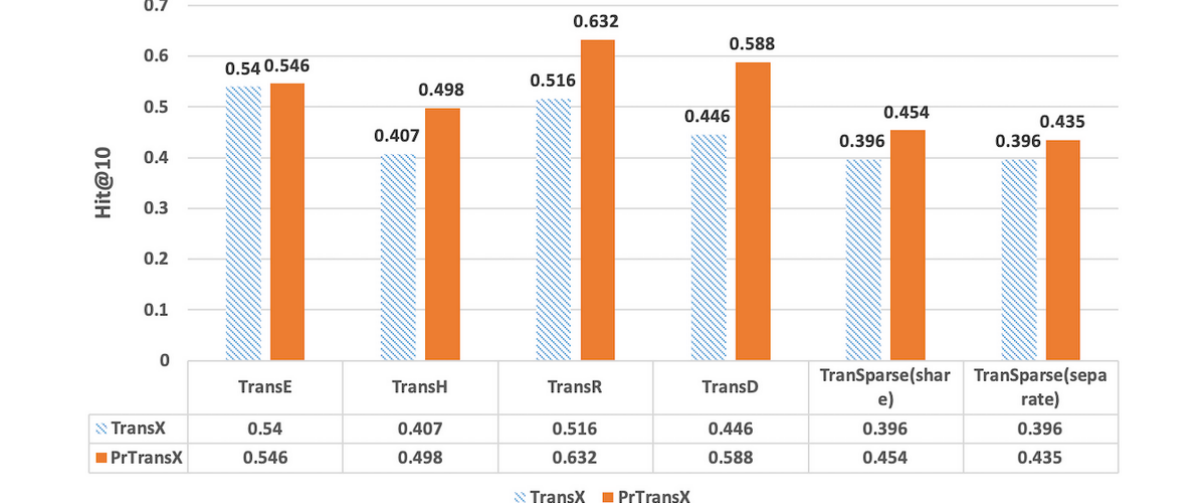
Figure 3. Proportion of corrected entities ranked in the top 10 of the tested algorithms.